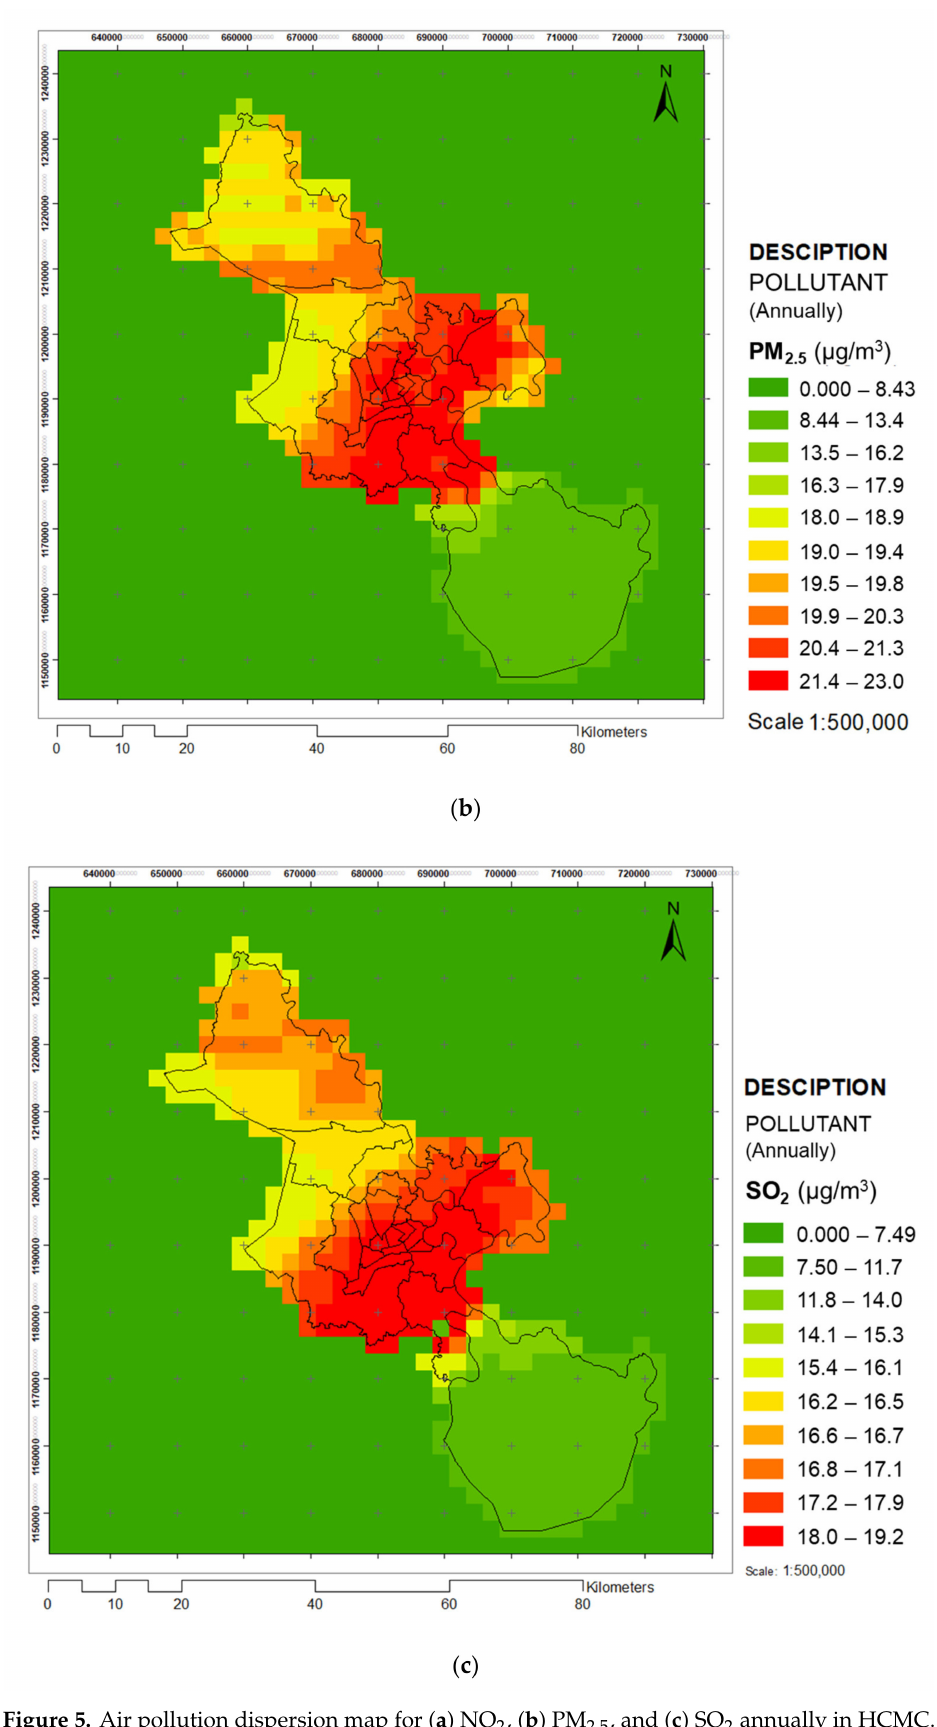
Figure 5. Air pollution dispersion map for ( a ) NO 2 , ( b ) PM 2.5 , and ( c ) SO 2 annually in